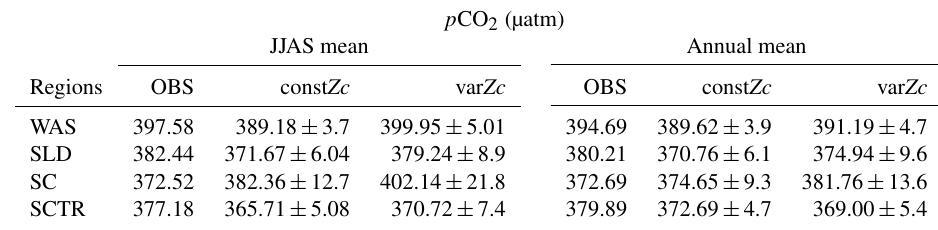
Table 2. Same as Table 1, but for p CO 2 . Units are µatm.